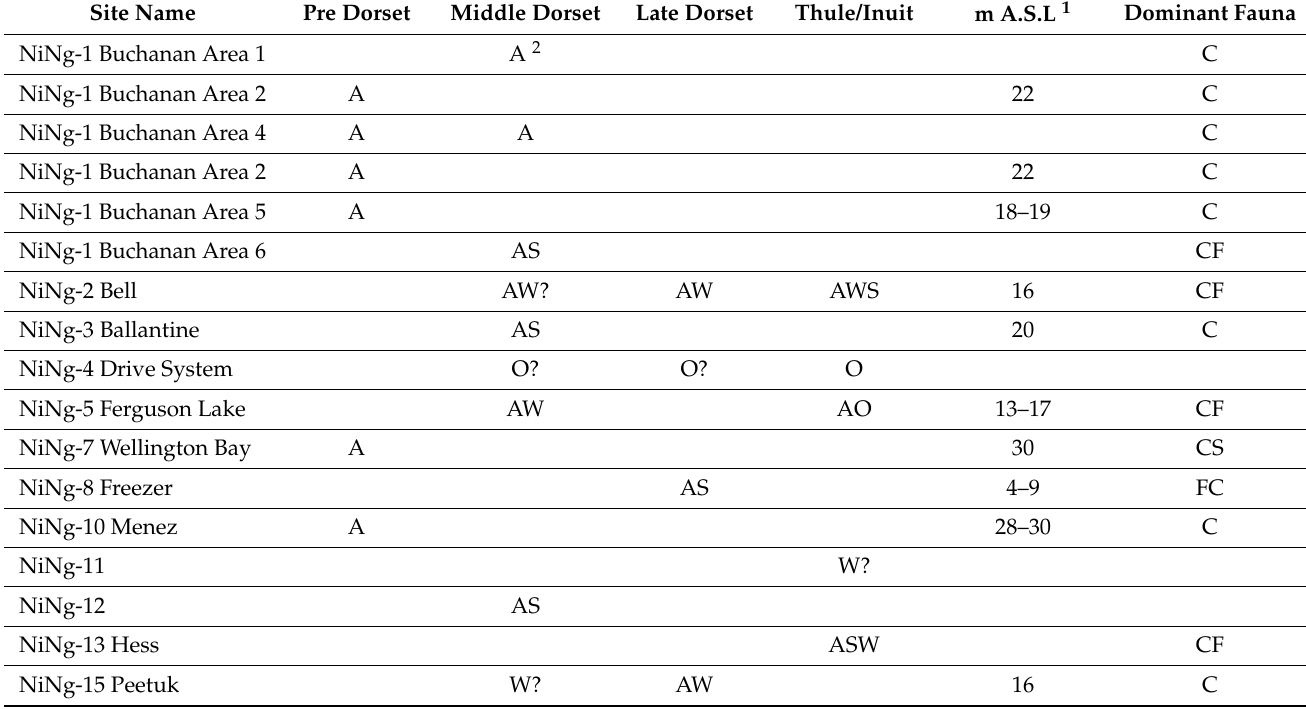
Table 2. Summary of Iqaluktuuq archaeological